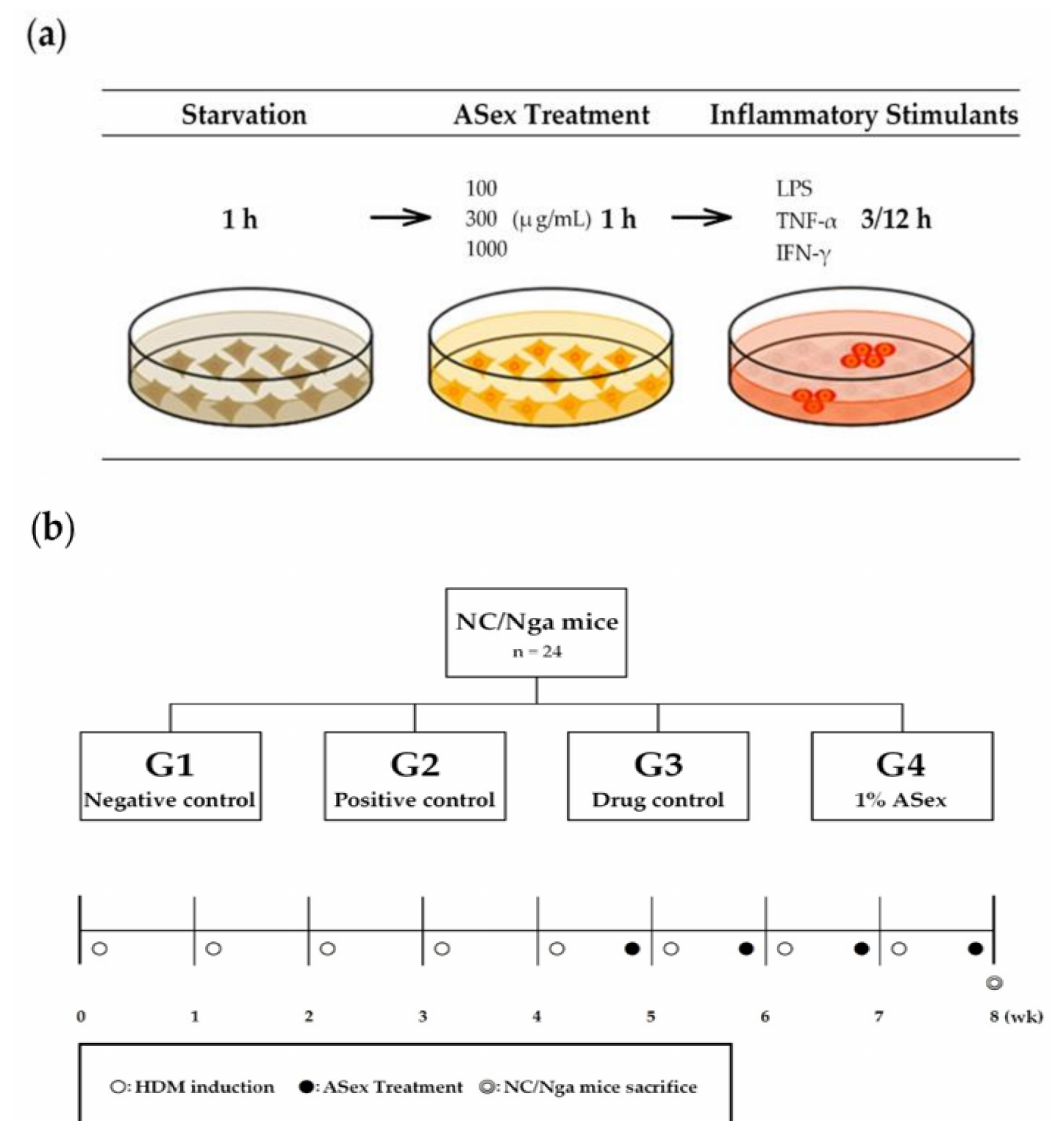
Figure 1. Overview of the in vitro and in vivo experiments. ( a ) The three steps for the induction of an inflammatory condition on cells; ( b ) Group names and descriptions for the 24 NC / Nga mice and schedules for the induction of inflammatory skin lesions on the skin and / or ears. LPS: lipopolysaccharide. TNF- α : tumor necrosis factor-alpha. IFN- γ : interferon-gamma. h: hour. G: group. HDM: house dust mite ointment. ASex: Alnus sibirica extract. Wk: